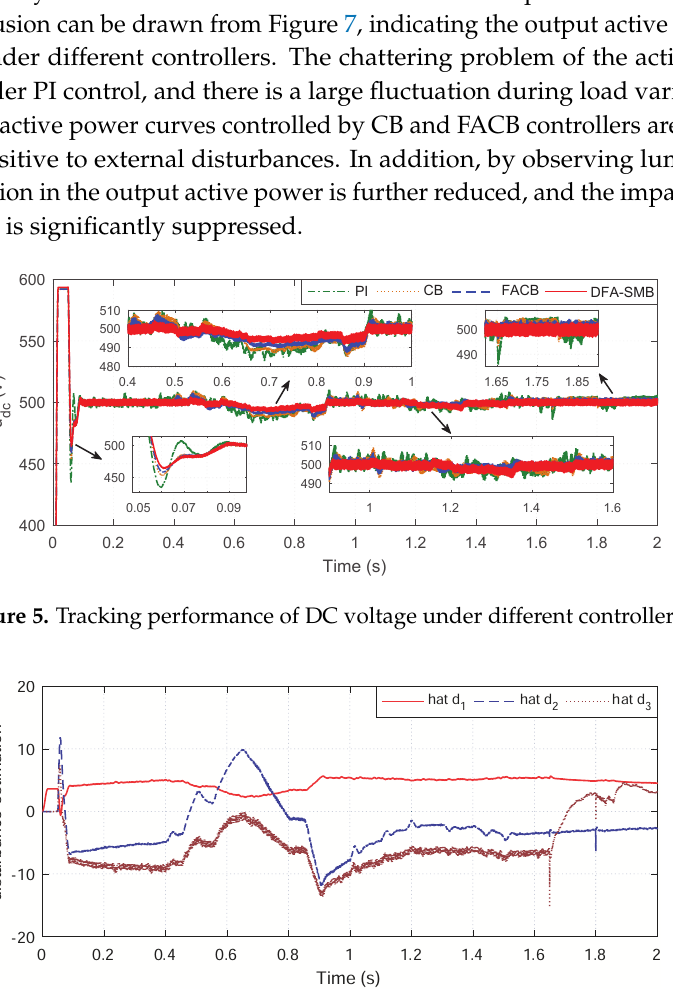
Figure 6. Lumped disturbances observed by disturbance-observer (DO).